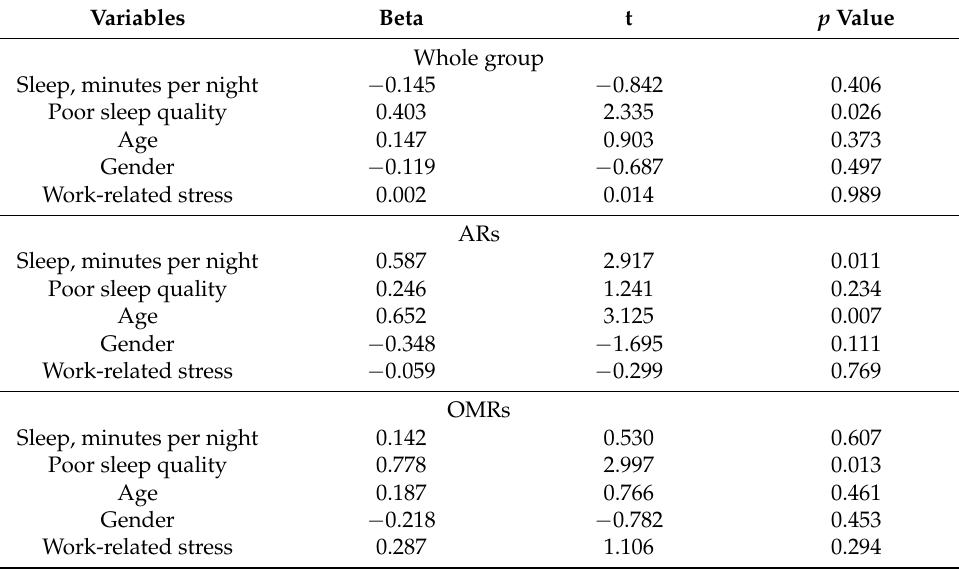
Table 4. Determinants of daytime sleepiness. Multiple linear